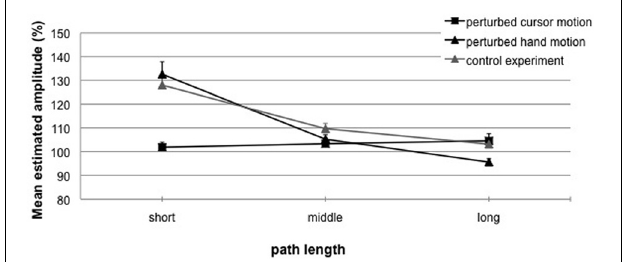
FIGURE 4 | Experiment 1. Mean estimated amplitude (%) for perturbed cursor motions (squares) and perturbed hand motions with visual feedback in phase 1 (black triangles), and perturbed hand motions without visual feedback in phase 1 (gray triangles) as a function of length variation. A performance of 100% indicates exact replications. Error bars represent the standard error of the